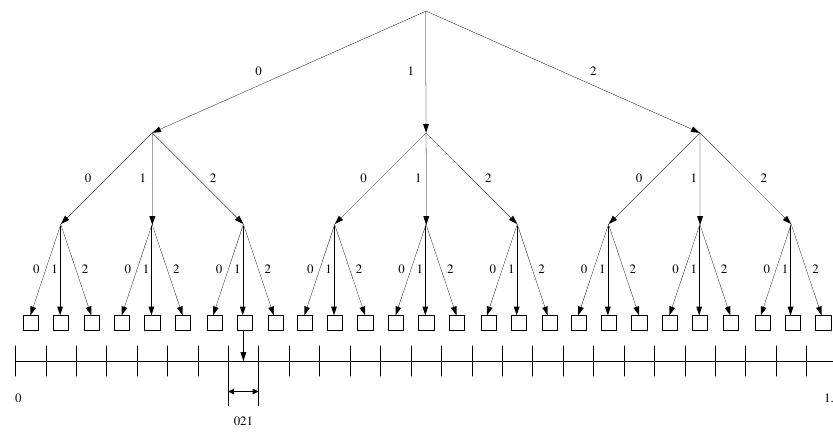
Figure 4. Code assignment by successive partitioning of a number